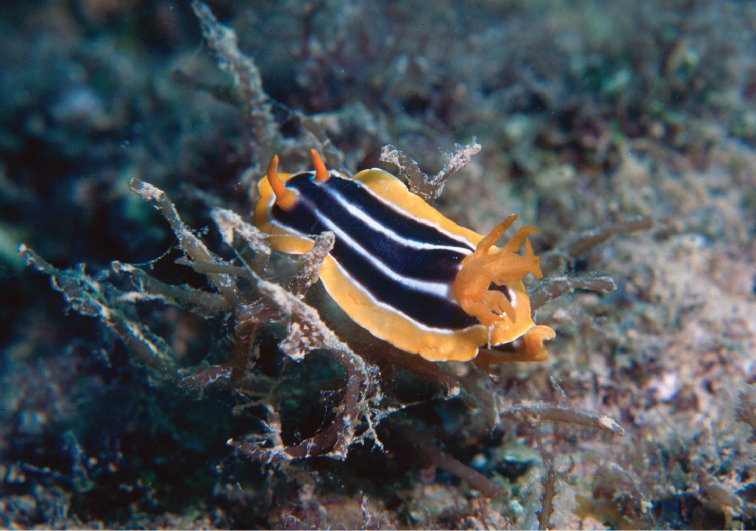

Chromodoris
africana Eliot, 1904, photograph E Pridgen.